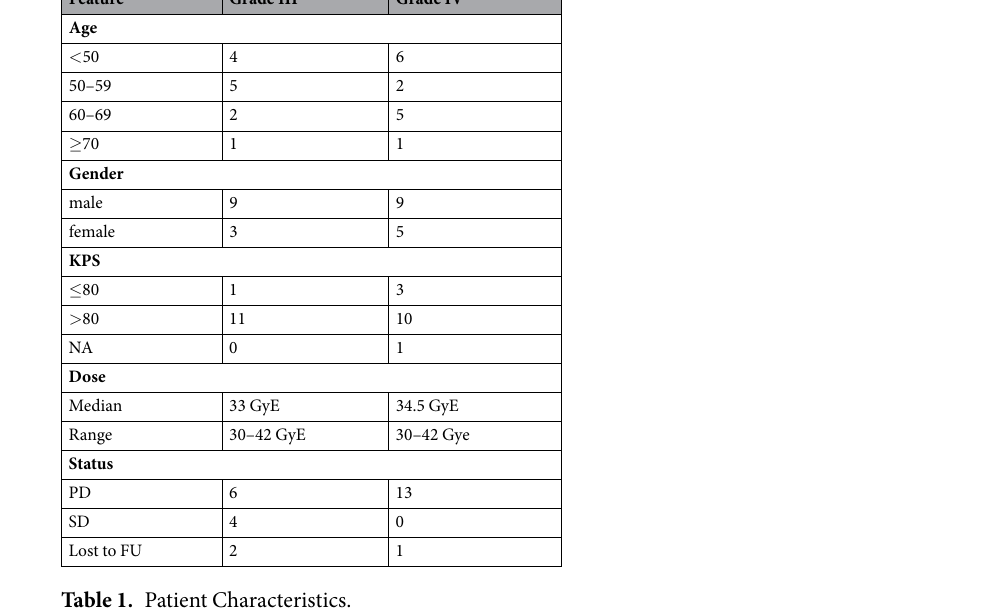
Table 1. Patient